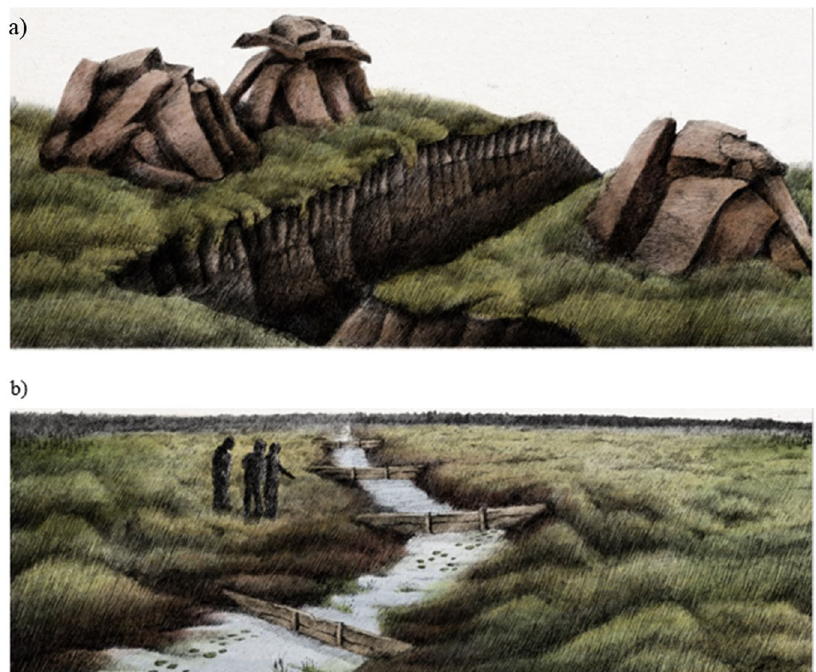
Fig. 1 Future scenarios of human impacts on extratropical peatlands. a Draining and mining. Peatlands are typically drained by digging ditches. Dried-out peat layers become susceptible to rapid decay and can be mined for peat blocks, which can be used to generate energy when burned, and peat moss and Sphagnum peat can be used for compost and as a growing media for horticulture. Drained peat surfaces can also be converted into large-scale agricultural fi elds or for cattle grazing. b Restoration. Peatland restoration and rewetting typically involve drainage blocking and recolonization of the site with native plant species. Together this can lead to restoring net peat accumulation, carbon storage, and increased biodiversity. Artist: Patrick